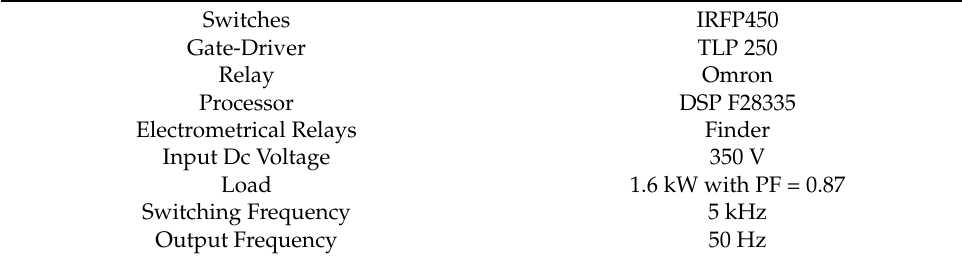
Table 10. Characteristics of the Prototype.